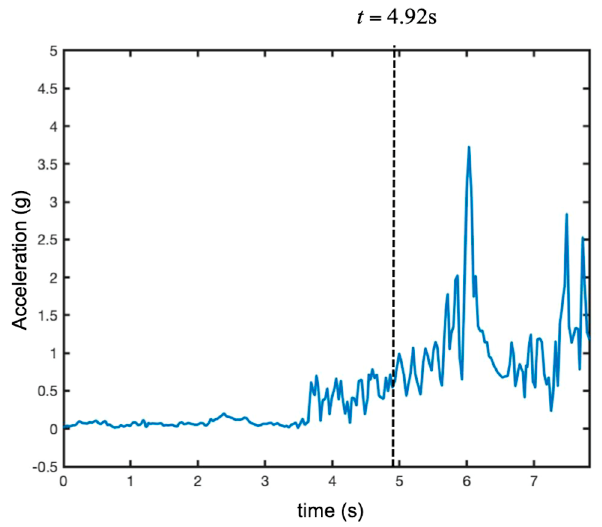
Figure 18. Recorded acceleration modulus of the UAV during maneuver 1 (i.e., take-off and rapid running away).